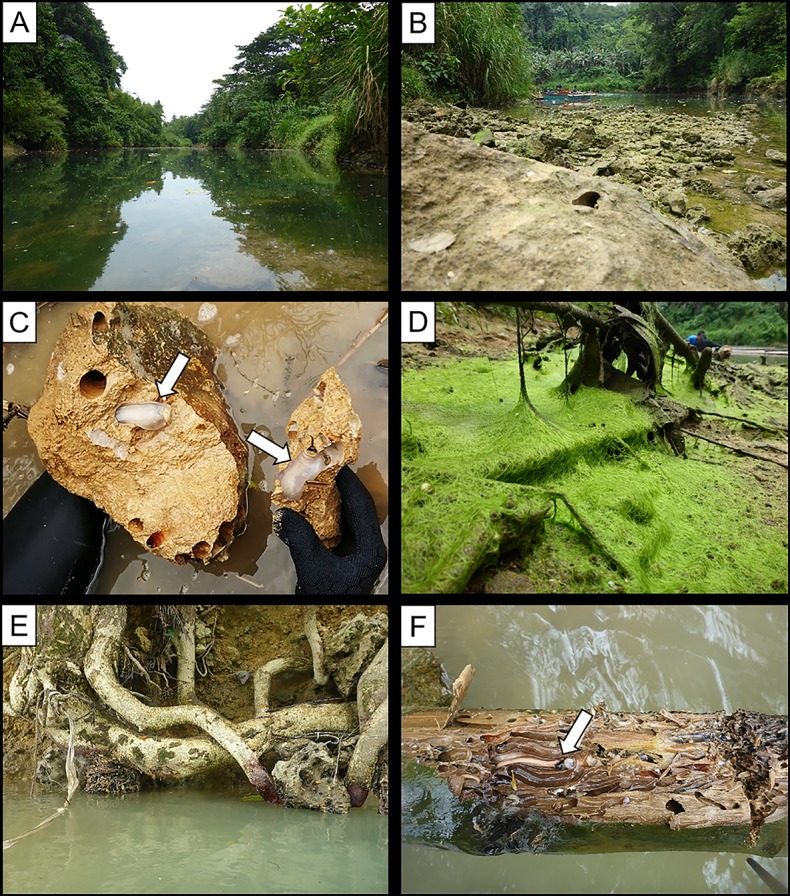
Photographs of the study site.(A) Abatan River bordered by heavily vegetated floodplain. (B) Exposed limestone bedrock and associated rubble. (C) Stone-boring shipworm Lithoredo abatanica in limestone bedrock. (D) Limestone outcrops variably coated by alga. (E) Exposed tree roots along banks of Abatan River. (F) Abundant wood clasts on submerged stream bed colonized by wood-boring shipworm Nausitora sp.